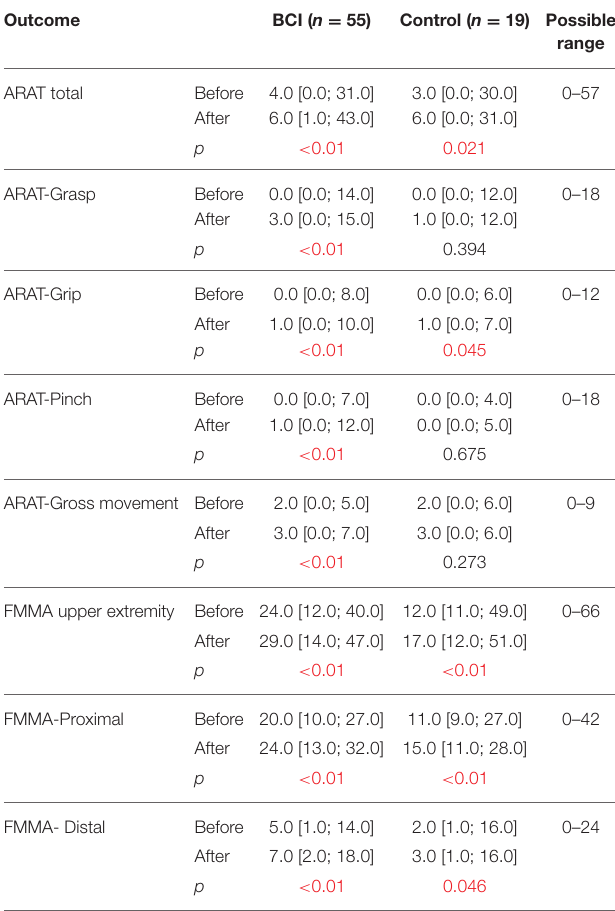
TABLE 3 | Efficacy measures by ARAT and FMMA scores for each study group (all randomized patients). Outcome BCI ( n = 55)